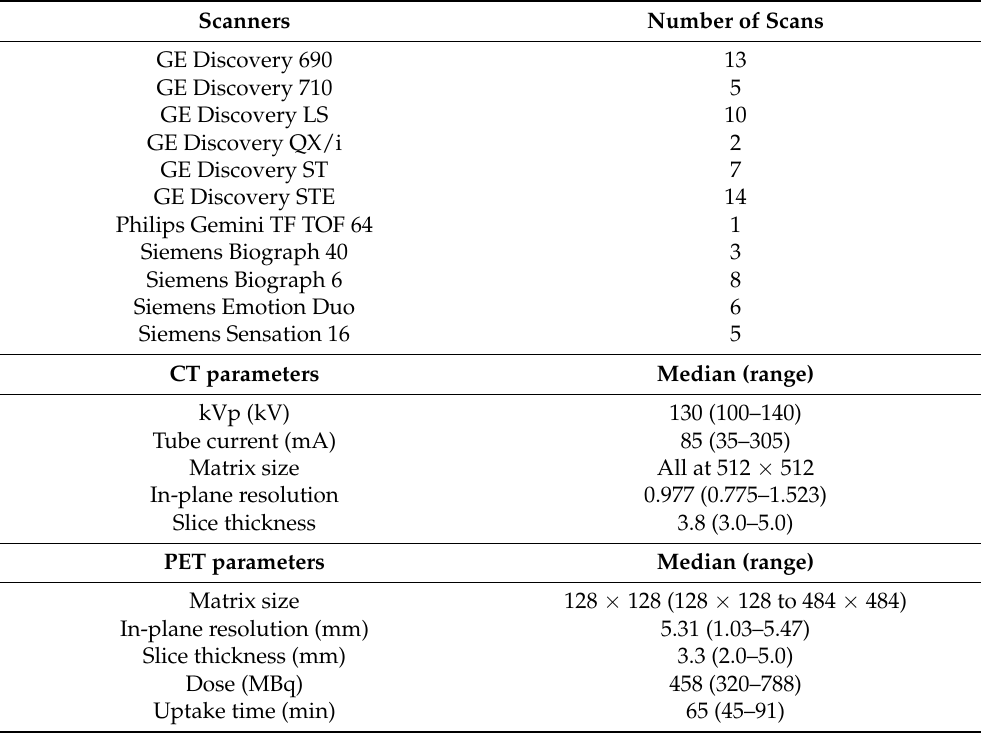
Table 1. Scanner and acquisition